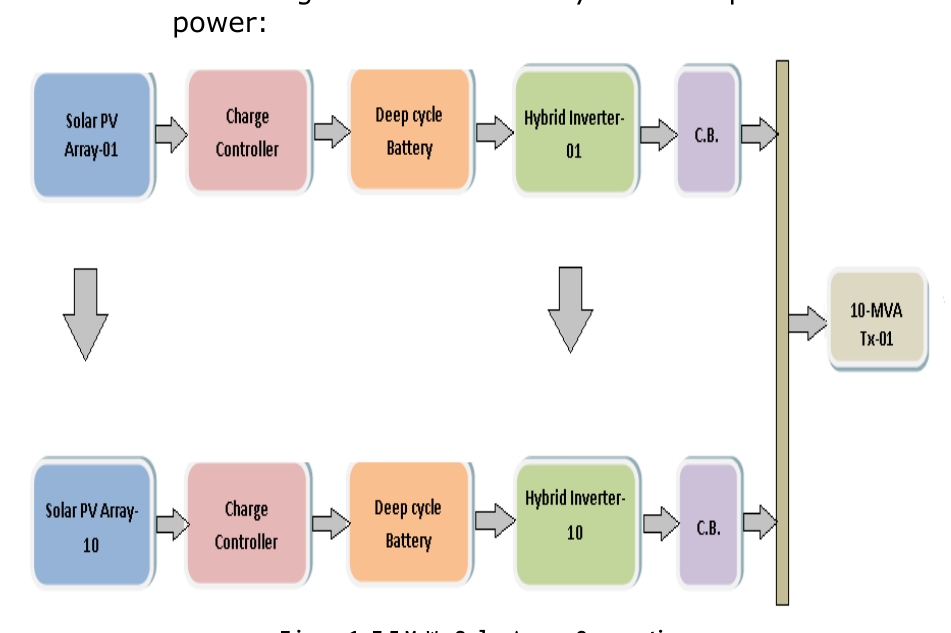
Figure 1. 7.5 MW Solar Array Connections